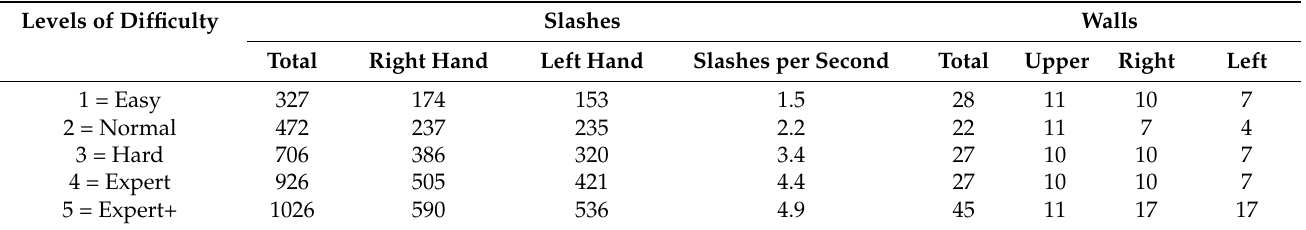
Table 1. Descriptive data from the various levels of difficulty in the active VR game “Beat